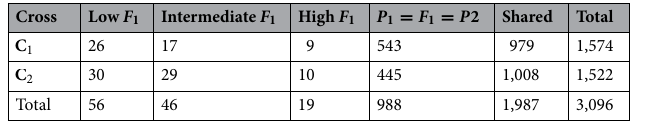
Table 4. Number of GO terms enriched in “Biological Process” (BP) per